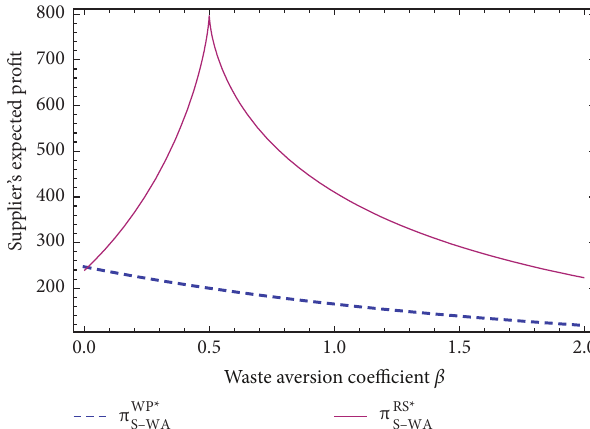
Figure 7: Effect of β on supplier’s expected profit.